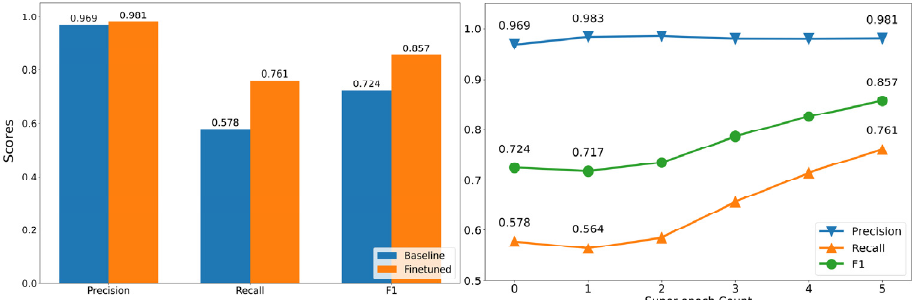
13 of 18 Figure 10. Change in frame ‐ to ‐ frame segmentation consistency for two sample recordings, with positive values denoting an improvement in temporal stability. 3.3. Quantitative Evaluation Model performance was assessed using a test dataset (n = 111), which was annotated with the aid of a hand ‐ held ultrasound and a commercial vein ‐ finder device as verification [39]. Precision and recall values were selected to evaluate model performance, as much of the image consists of non ‐ arm and non ‐ vein regions, leading to a large class imbalance and oversized true negative classification. For both the baseline and fine ‐ tuned models, precision remained high at above 0.96, with a slight improvement (0.012) after finetuning. Recall for the baseline model was low at 0.578 and increased significantly to 0.761 after finetuning. The low initial recall can be attributed to the fact that the initial “noisy” dataset contained only annotations for prom ‐ inent veins that could be easily identified, leading to the model converging towards a more conservative vein discrimination process that results in higher false negative counts. We further investigated the model’s performance on the test set across super ‐ epochs.